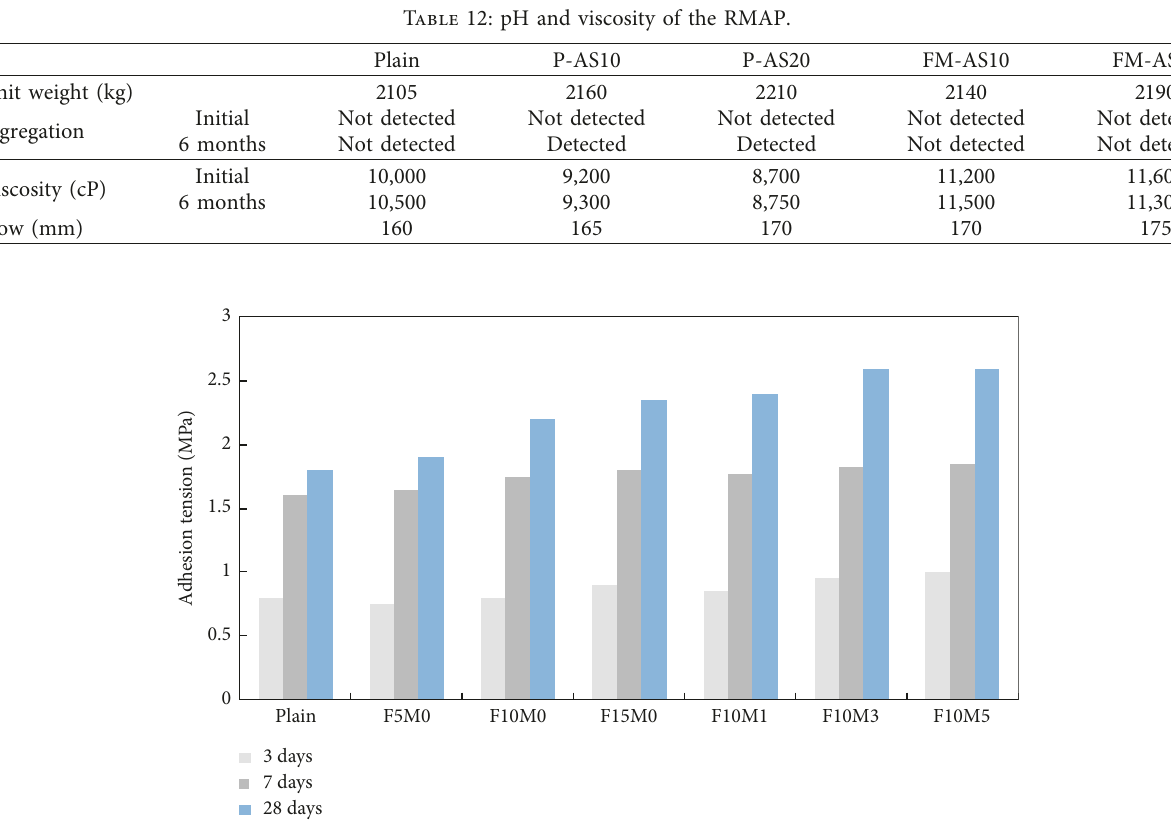
2 according to curing age.